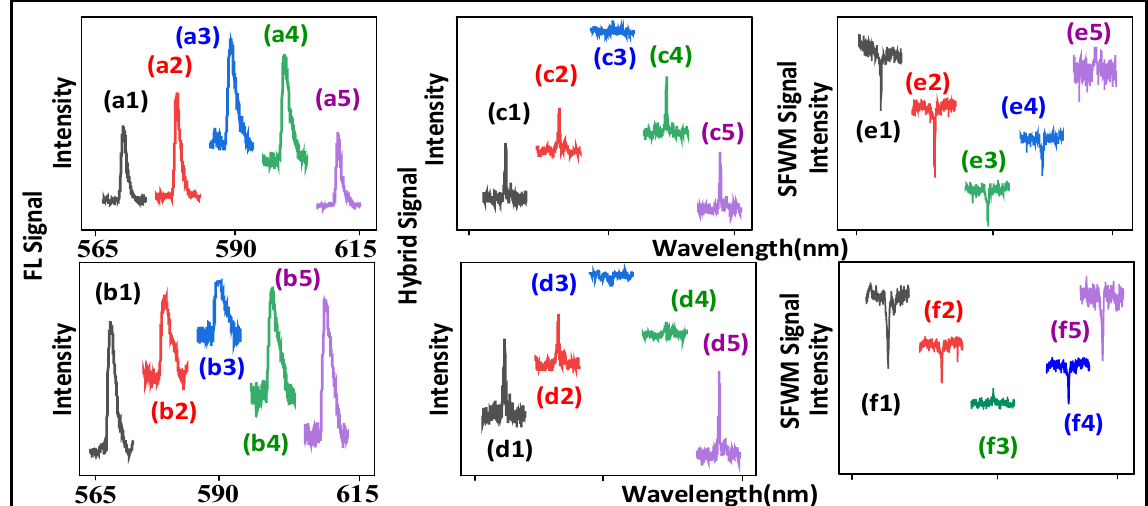
Figure 7. ( a , b ) show FL cross-interaction observed from Eu 3+ doped in molar ratio (0.5:1) BiPO 4 at different E 1 wavelengths (577.4 nm, 584.4 nm, 587.7 nm, 592.4 nm, 612.4 nm) and E 2 scanned from 567.4 nm to 607.4 nm at PMT1 and PMT2, respectively, at the near time gate (1 μ s). ( c , d ) show hybrid cross-interaction at the middle time gates (100 μ s). ( e , f ) show SFWM cross-interaction at the far time gate (500 μ s). The other experimental condition is the same as ( a , b ),